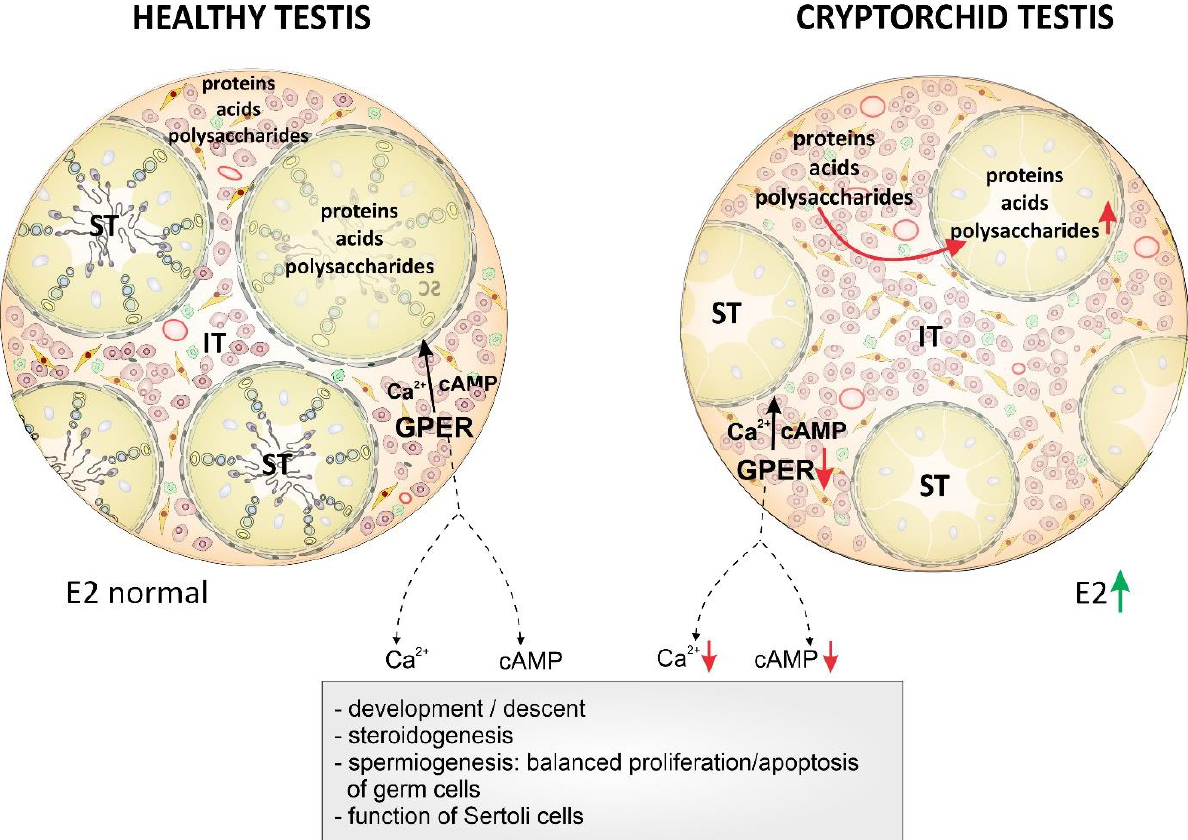
Figure 4. Schematic representation of the biochemical and molecular status of healthy and cryptorchid horse testes demonstrating the possible effects of GPER downstream pathways via cAMP and Ca2+ on the testes from development to maturity under both normal in healthy testes and the increased estrogen levels in cryptorchid testes.